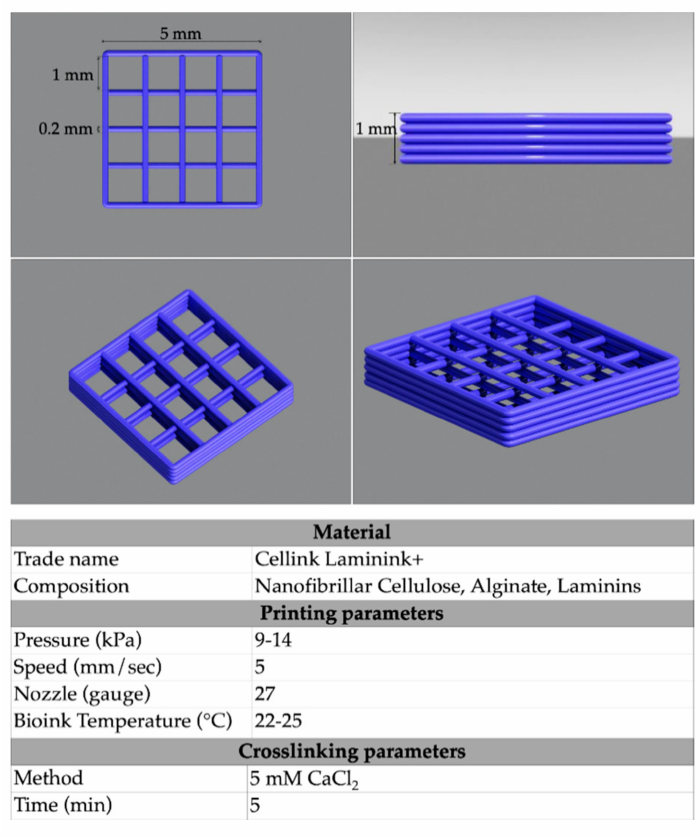
Figure 9. 3D sca ff old design: upper panels show top ( left ) and side ( right ) views, bottom panels show perspective projection images of the 3D NFC / A sca ff old. The table reports the materials and methods used for the 3D bioprinting of ASCs in the NFC / A